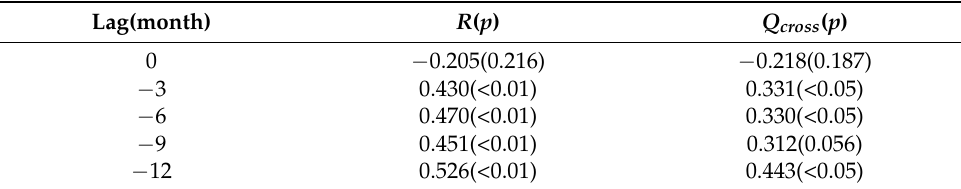
Table 2. Lag correlation coefficients between Multivariate ENSO (El Niño/Southern Oscillation) Index (MEI) and R and Q cross ,